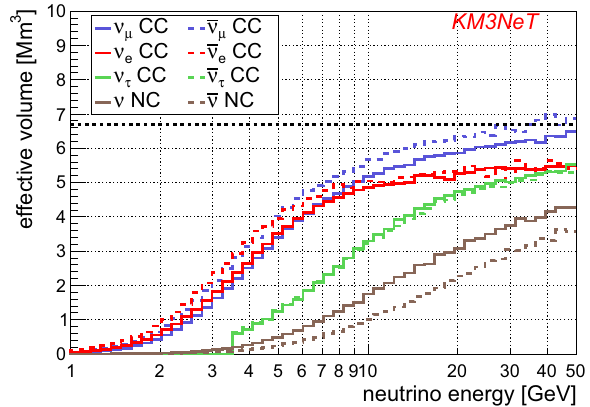
Fig. 1 Effective detector volume as a function of true neutrino energy E ν for different neutrino flavours and interactions. Events are weighted according to the Honda atmospheric neutrino flux model and averaged overthezenithangle.Onlyeventsreconstructedandselectedasupgoing are used. The dashed black line indicates the instrumented volume of the detector